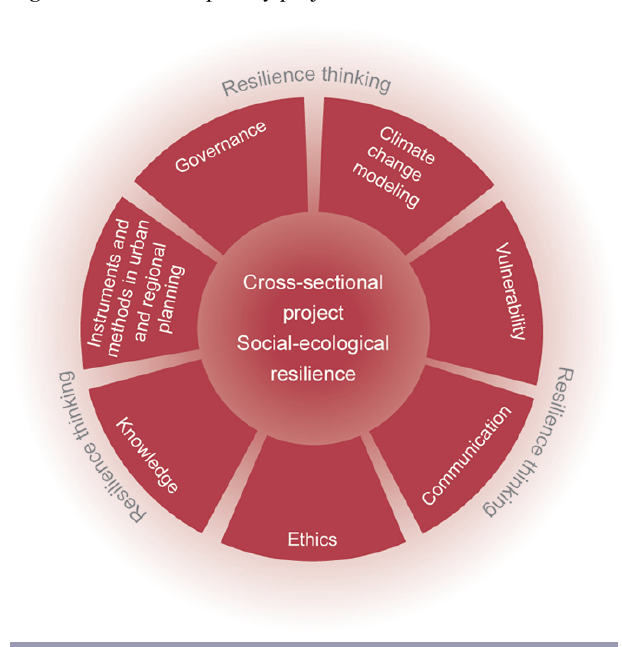
Fig. 1 . The interdisciplinary project structure.